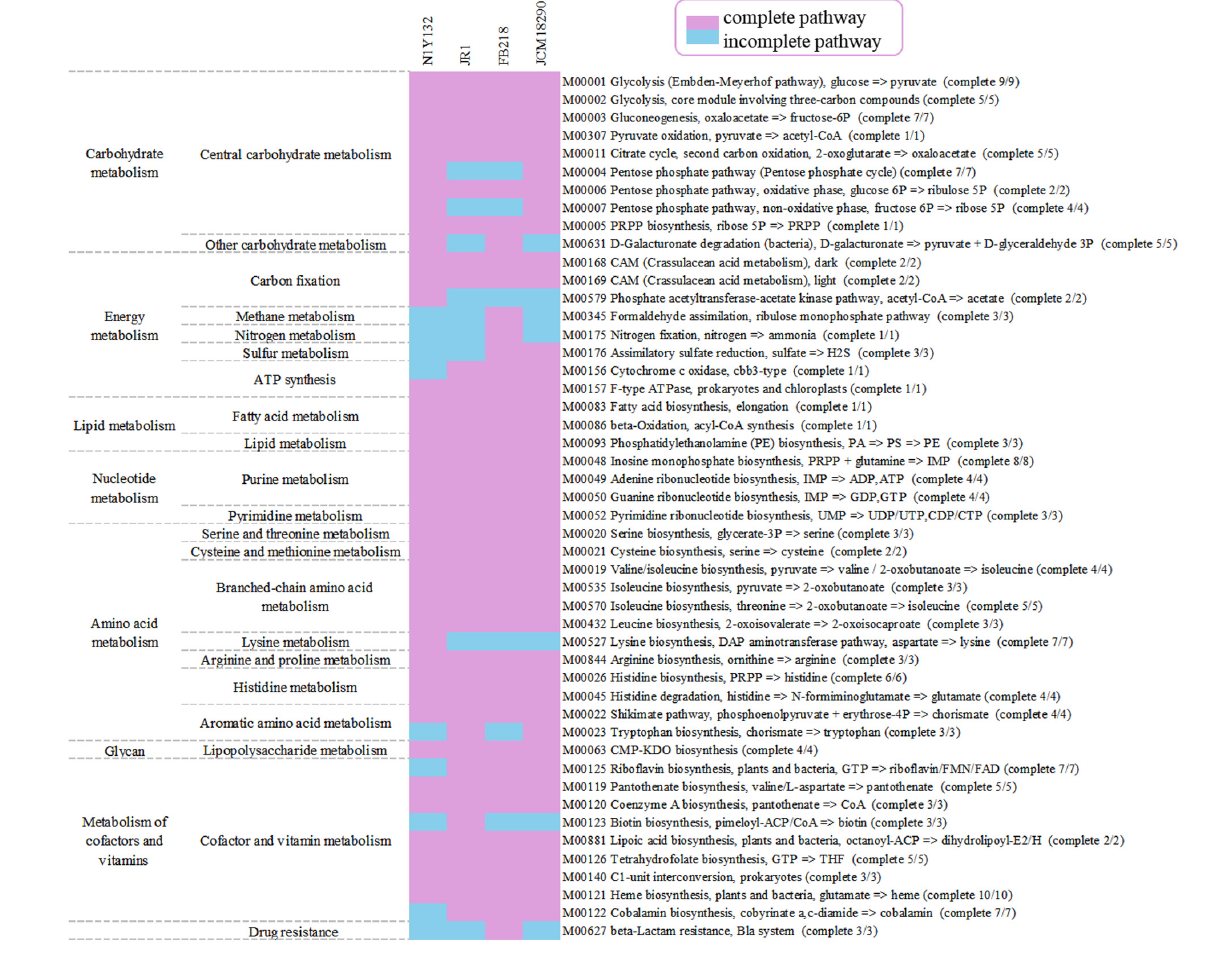
Frontiers in Marine Science |